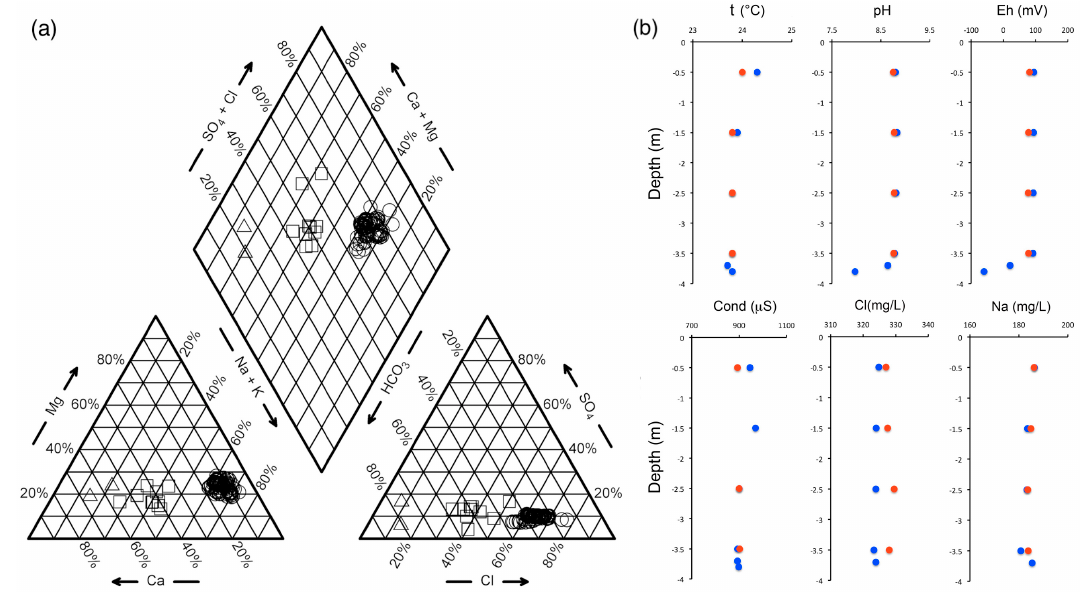
Figure 4. ( a ) Piper diagram. Open circles refer to lake water samples, squares refer to river waters and triangles to groundwater samples; ( b ) variations of temperature, pH, Eh, electrical conductivity, Cl and Na along the vertical profiles A (blue circles) and B (red circles).